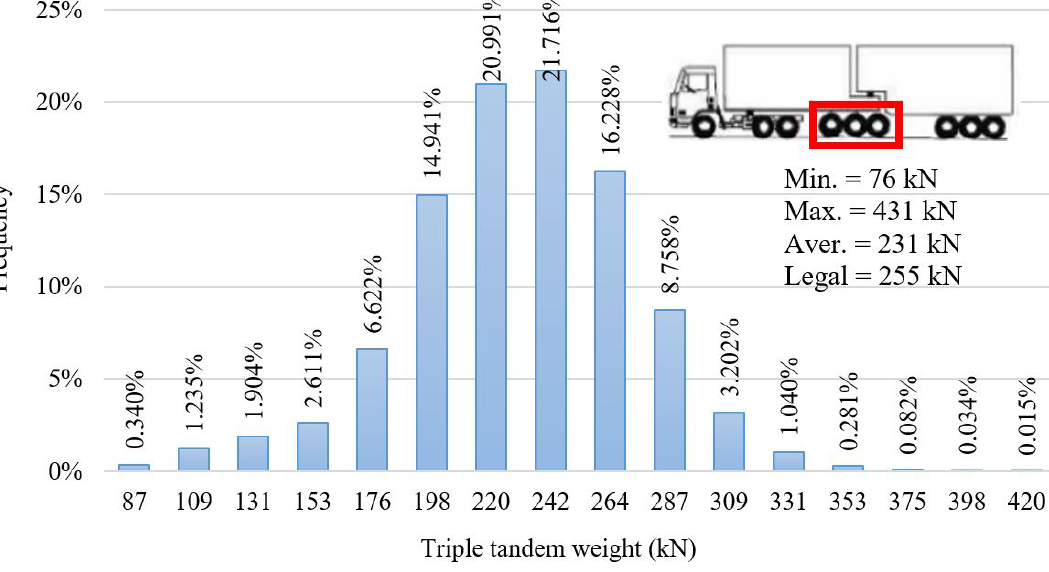
Figure 7. Histogram for weight for triple tandem for class 3M6, which the horizontal axis shows the average values for each interval (the histogram for both triple tandem are